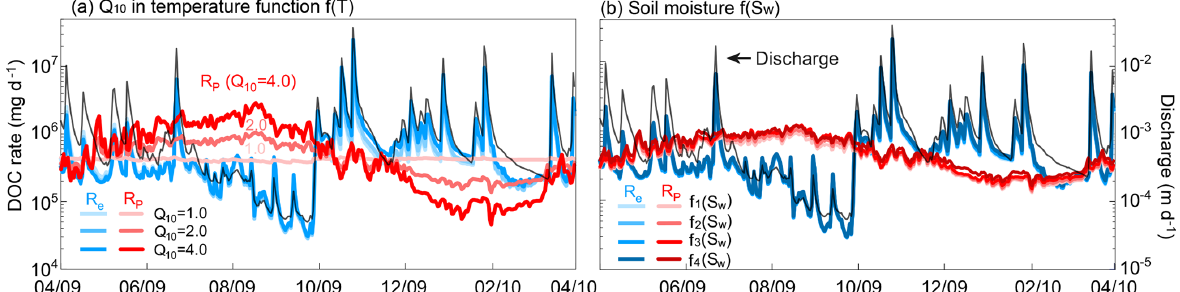
Figure 9. Sensitivity analysis of temporal DOC rates for (a) soil temperature f (T ) and (b) soil moisture f (S w ) . A varying Q 10 value in f (T ) had a larger influence on R p than varying f (S w ) . Neither f (T ) nor f (S w ) had a significant influence on R e . Instead, R e mostly followed the temporal trend of discharge, indicating the predominant control of hydrological conditions.